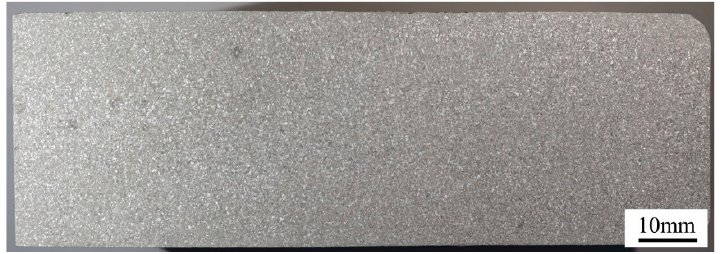
Figure 2. AA6063 thin slab prepared by VC process. ( a ) Photograph of the whole slab; ( b ) surface detail.